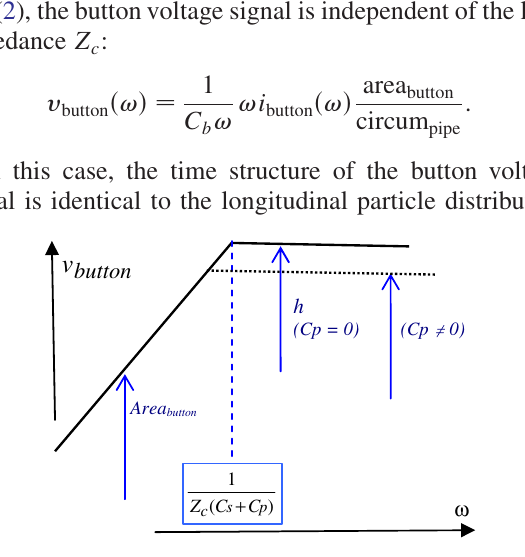
FIG. 1. (Color) Electrical button model, C formed by the surface of the electrode and the grounded wall, is the button radial capacitance. C and C p total electrode capacitance. h is the distance between the elec- trode surface and the